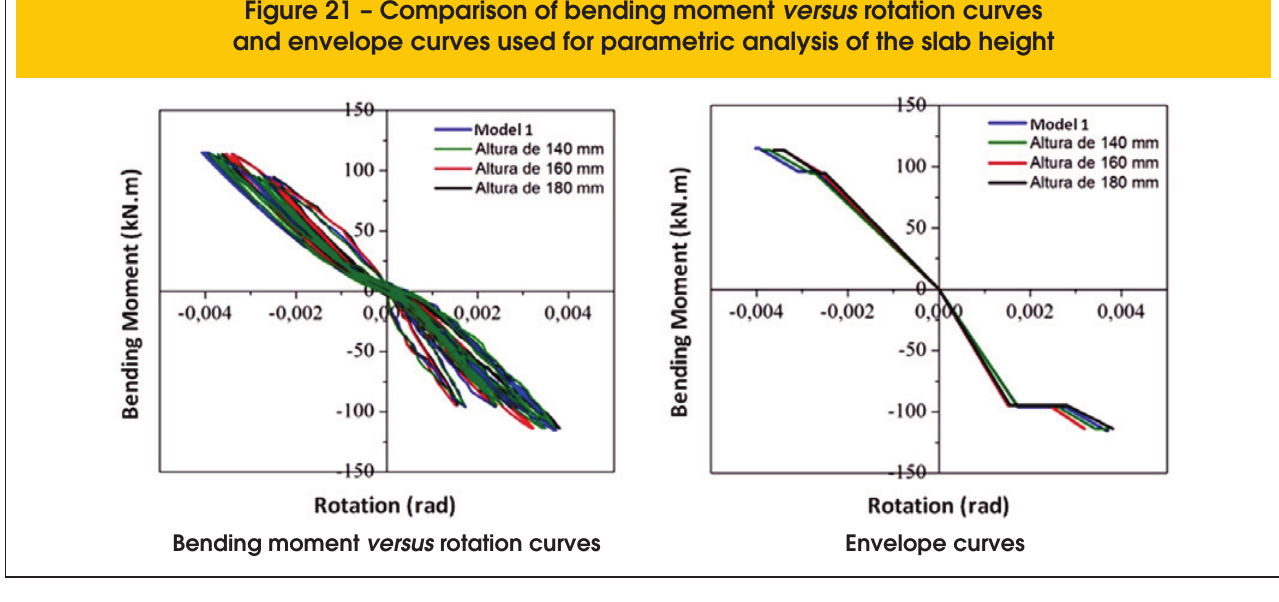
Bending moment versus rotation curves